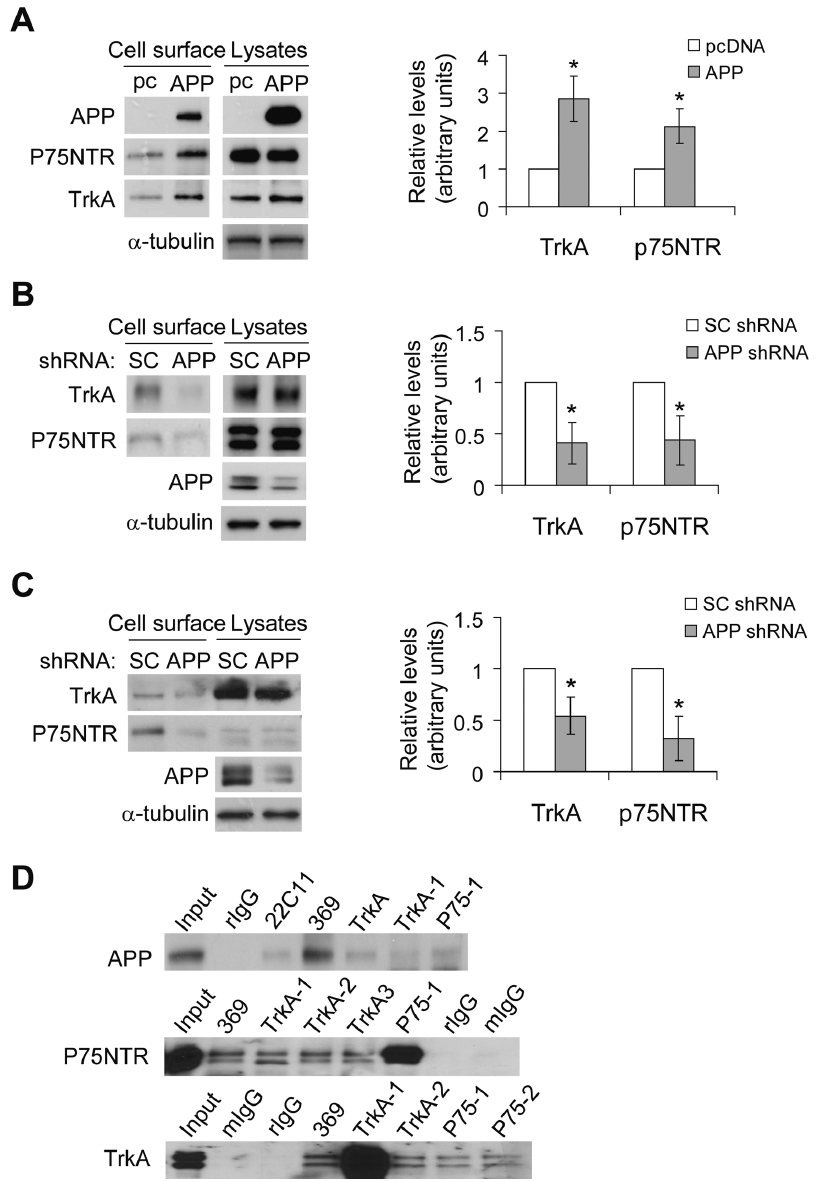
Figure 1. APP regulates cell surface levels of NGF receptors. (A) APP/APLP2 dKO cells were first transfected with p75NTR or TrkA. After splitting equally, cells were transfected with pc DNA (control) or APP. Cell surface proteins were biotinylated, affinity precipitated, and subjected to Western blotting. (B) PC12 cells were stably transfected with APP or scrambled control (SC) shRNA-containing vectors. Cell surface protein levels were analyzed by biotinylation. (C) Rat primary neurons were infected with APP or scrambled control (SC) shRNA-containing lentivirus for 5 d. Cell surface protein levels were analyzed by biotinylation. Protein levels were quantified by densitometry and normalized to those of controls for comparison (set as one arbitrary unit). Error bars indicate SEM. *: P , 0.05, n=3. (D) Equal protein amounts of PC12 cell lysates were incubated with rabbit IgG (rIgG), mIgG, APP antibodies (22C11 and 369), different TrkA antibodies (1–3) and P75NTR antibodies (1–2). Immunoprecipitated proteins were subjected to Western